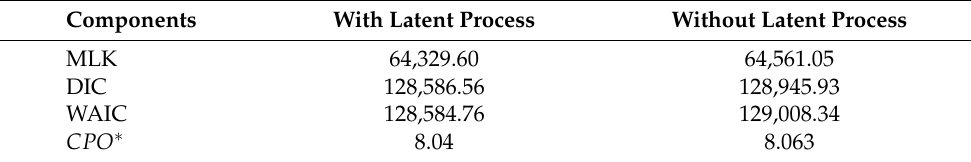
Table 3. Comparative Analysis of Bayesian models. All the evaluation metrics favor the model with random noise as the model had marginally improved performance than the model without random noise. Due to insignificant differences between the values of the metrics, both models may be used with proper